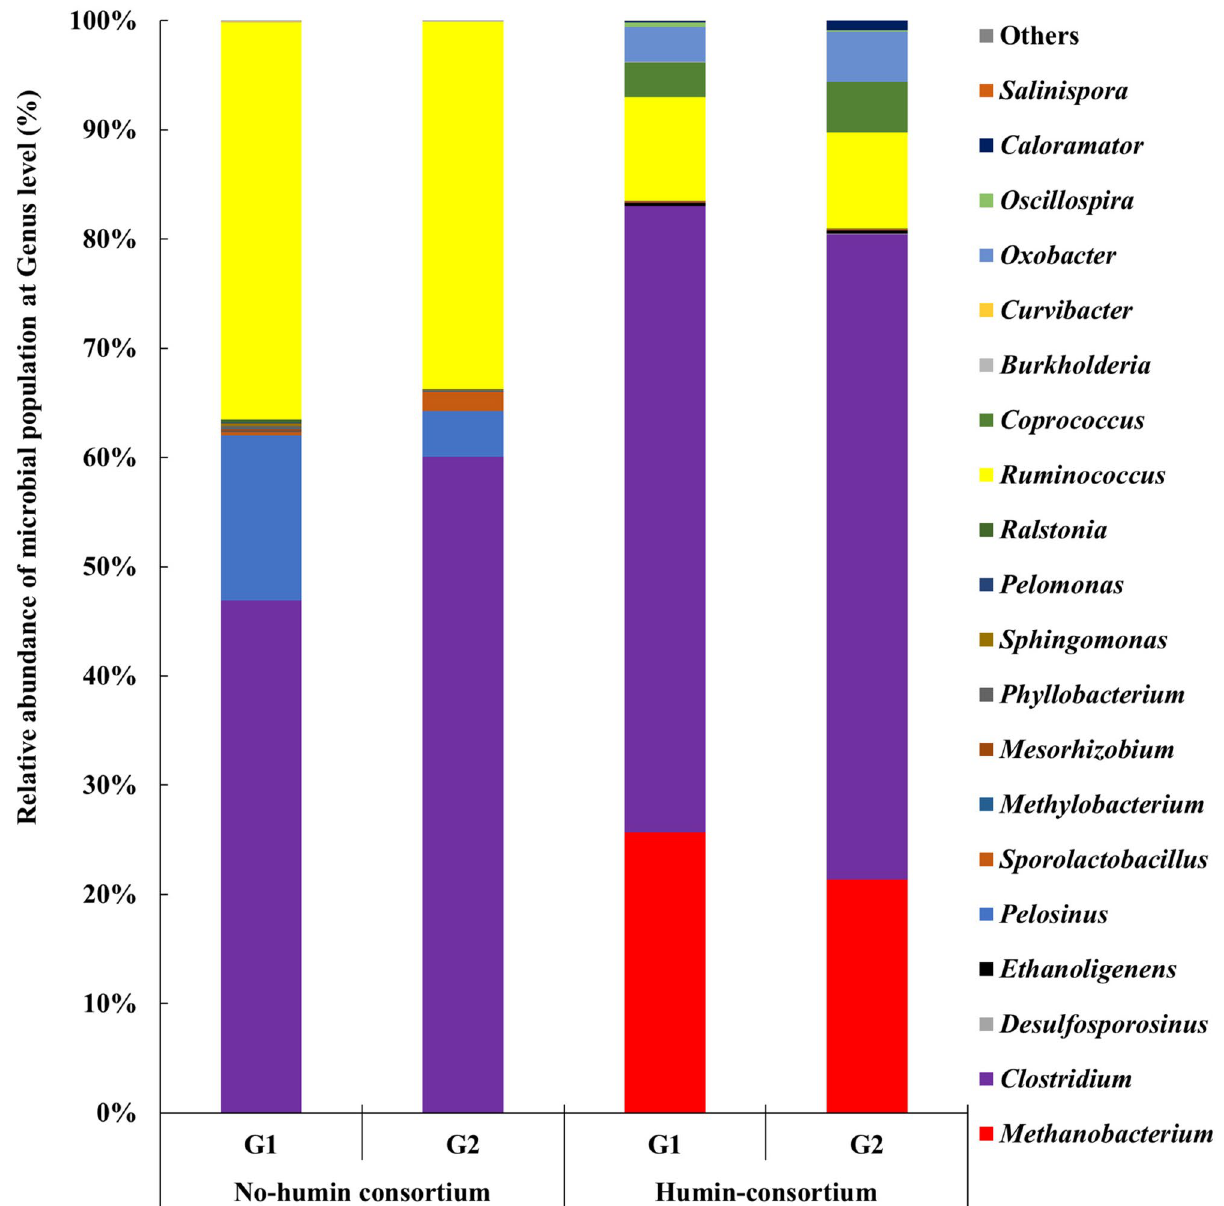
Figure 8. Community structures of the no-humin and humin consortia (35th generation) based on 16S rRNA gene sequencing. The data shows the community structures of two replicates (G1 and G2) of the consortia, individually. “Others” denotes the taxonomic groups with less than 0.02% abundance. In the figure, taxonomic groups are arranged as N-fixers, nifH -positive microorganisms and non N-fixers from bottom to cating the larger microbial population in the humin consortium. The nifH gene was only detected in the humin consortium at 10 5 copies/ml, and not detected in the no-humin consortium. These suggested that nitrogen- fixing microorganisms were not present at a detectable level by the qPCR analysis adopted in the no-humin con- sortium but were present in the humin consortium. However, the observed small population of nitrogen-fixing microorganisms did not agree with the stable BNF activity detected both in the humin and no-humin consortia following enrichment. The microbial community structures in the humin and no-humin consortia were determined by next genera- tion amplicon sequence of partial 16S rRNA genes using Miseq (Ilmina) (Fig. 8). Bacteria, mostly Firmicutes, accounting for 73–77% of the relative abundance, dominated the humin consortium. Clostridium, Ruminococcus and Oxobacter, belonging to Clostridiales, were the major genera of detected Firmicutes. Other Clostridiales such as Desulfocporosinus, Ethanoligenens, Coprococcus, Oscillospira and Caloramator were detected as the minor populations. Other than Clostridiales, the detected genera of Bacteria were Sporolactobacillus (Bacillales), Phyl- lobacterium (Rhizobiales), Sphingomonas (Sphingomonadales) and Ralstonia (Burkholderiales) accounting for several percentage. Archaea, mostly Methanobacterium, occupied 22–26% of relative abundance in the humin